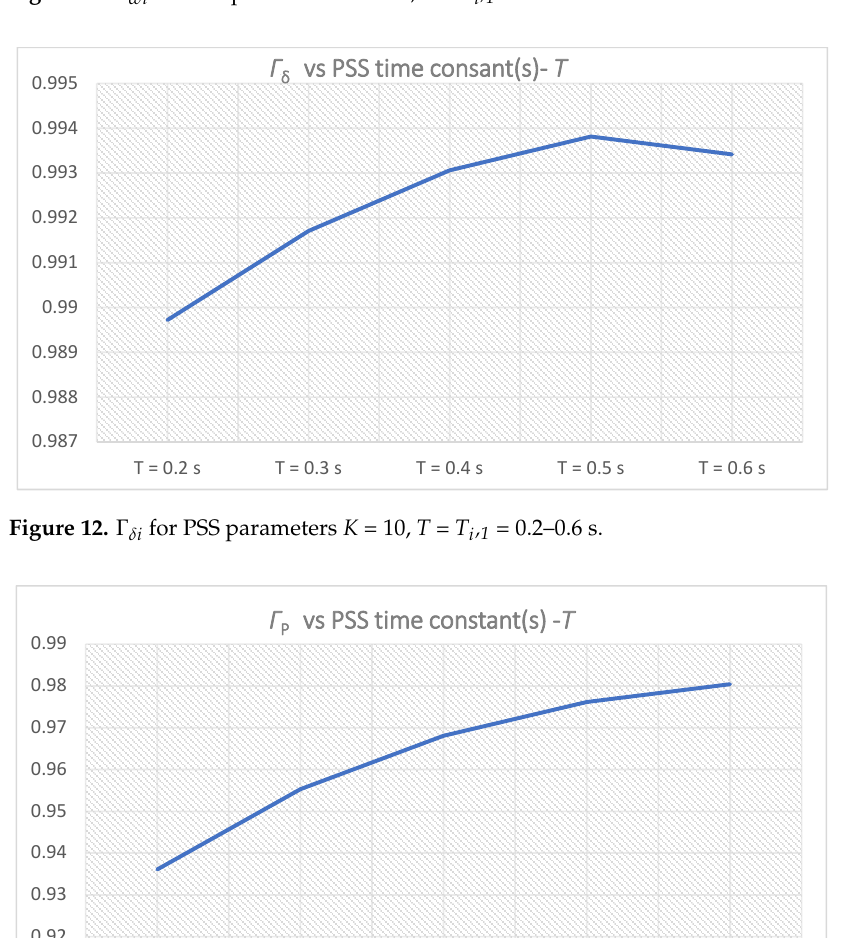
Figure 11. Γωi for PSS parameters K = 10, T = Ti, 1 = 0.2 – 0.6 s.